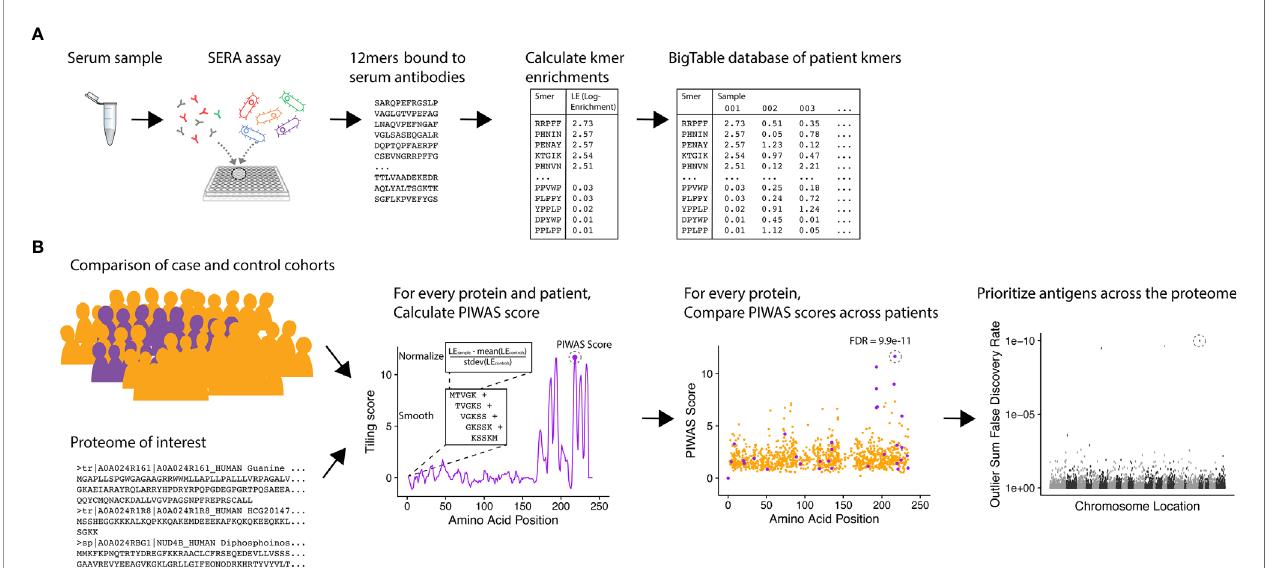
FIGURE 1 | PIWAS discovers candidate disease antigens through proteome-wide analysis. (A) Case and control specimens are processed using SERA to generate a dataset of 12mer amino acid sequences bound by serum antibodies. Each 12mer is broken into kmer components and log-enrichments of these kmers are calculated, where enrichment indicates the number of observations compared to expectation based on amino acid frequency. (B) As input for the PIWAS algorithm, case and control cohorts are identi fi ed (purple, cases; gold, controls) as well as the target proteome. For each individual in the case and control cohorts and protein in the proteome, PIWAS scores are calculated by tiling kmers onto the protein sequence, smoothing over a window of these kmers, normalizing to the background signal in the controls, and calculating the maximum value. PIWAS scores are compared across all case and control samples to detect proteins whose scores are signi fi cantly greater in some subset of the case population than in the control population. Antigens are then rank-ordered by one or more statistics across the entire